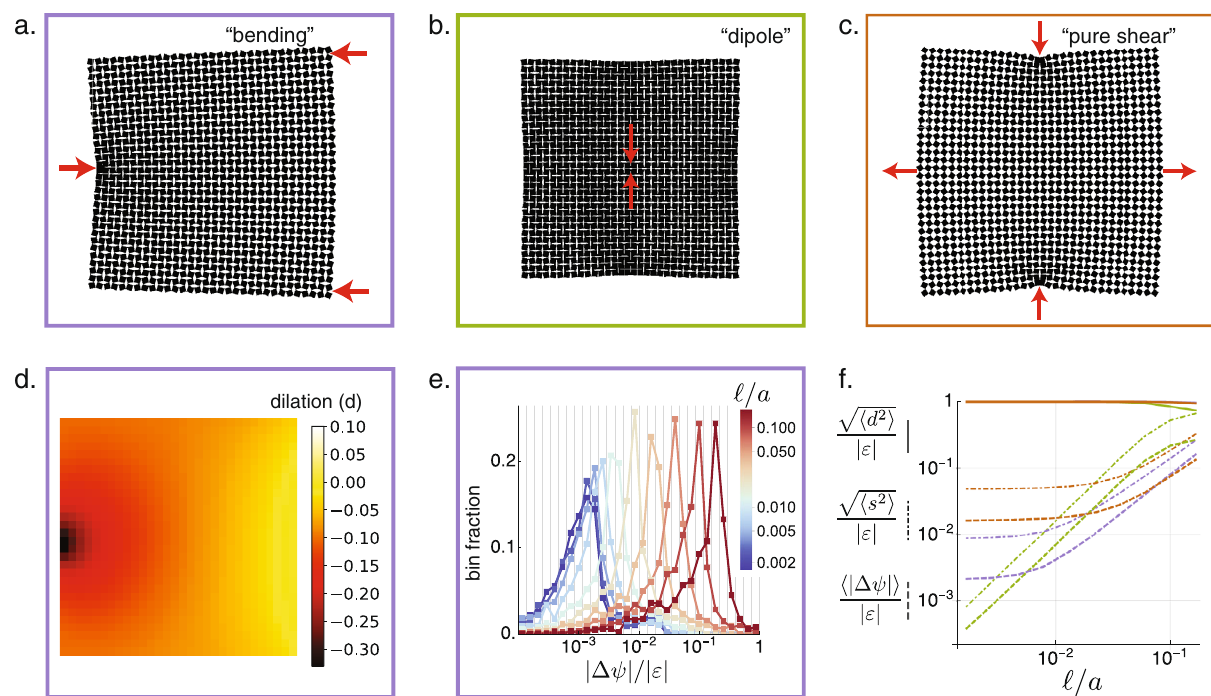
Fig. 2 Deformations of dilational metamaterials are angle preserving. a A fi nite-element simulation of a three-point bending test (the “ bending ” load) locates force-balanced (relaxed) states of the RS-based elastic metamaterial subject to displacements on the boundaries that are incompatible with uniform dilation. b The “ dipole ” load consists of closing a single central pore by displacement of points on opposite sides of the pore, thereby generating a localized dilation in the bulk of the material. c The “ pure shear ” load consists of compression along one axis and extension along the other, which is nevertheless compatible with a spatially varying pure dilation fi eld. d The resulting dilation fi eld under the “ bending ” load varies widely across the sample, including nonlinear compression and expansion. e Nevertheless, the angle changes ∣ Δ ψ ∣ remain small, even in proportion to the average strain magnitude ∣ ϵ ∣ . Here, the histogram is shown on log-linear scale, with each square marker giving the fraction of unit cells with that angle change, and which tend to decrease as the hinge size decreases. The preservation of angles is the de fi ning feature of conformal maps. f For all loads (colored in correspondence with the box outlines in ( a – c )) the dilation fraction (solid lines) is nearly unity, and the deviation from unity is captured by the shear fraction (dot dashed lines), which for linearly small shears is the complement of the dilation fraction, and at the smallest hinge size ranges between 0.001 and 0.05. Both the shear fraction and the normalized average angle change (dashed lines) decrease with decreasing hinge size. The plateau in the bending and pure shear loads can be attributed to non-continuum lattice